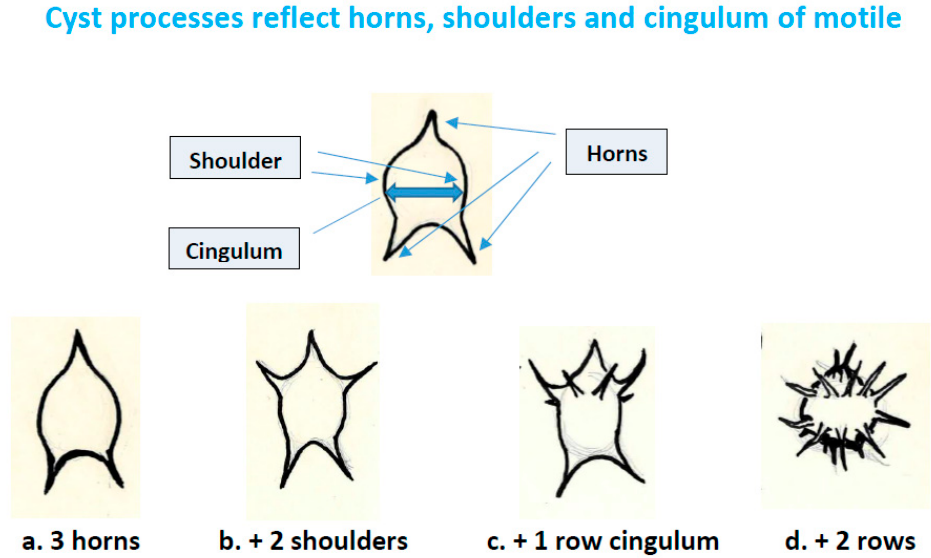
Figure 4. Reflection of horns, shoulders and cingulum from motile dinoflagellates on cysts.